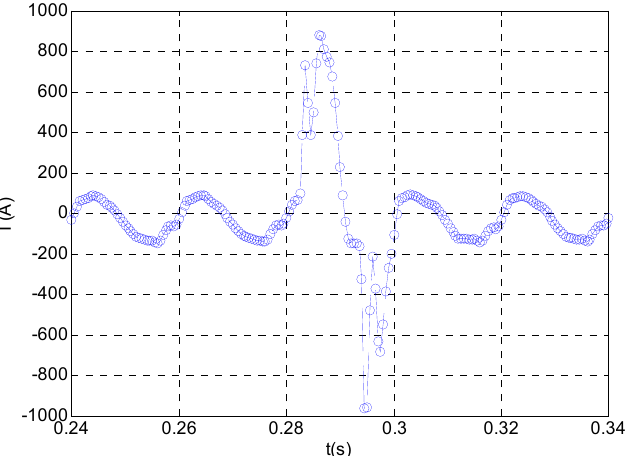
Figure 1. Real case of a self-extinct fault in a 10 kV underground distribution system.